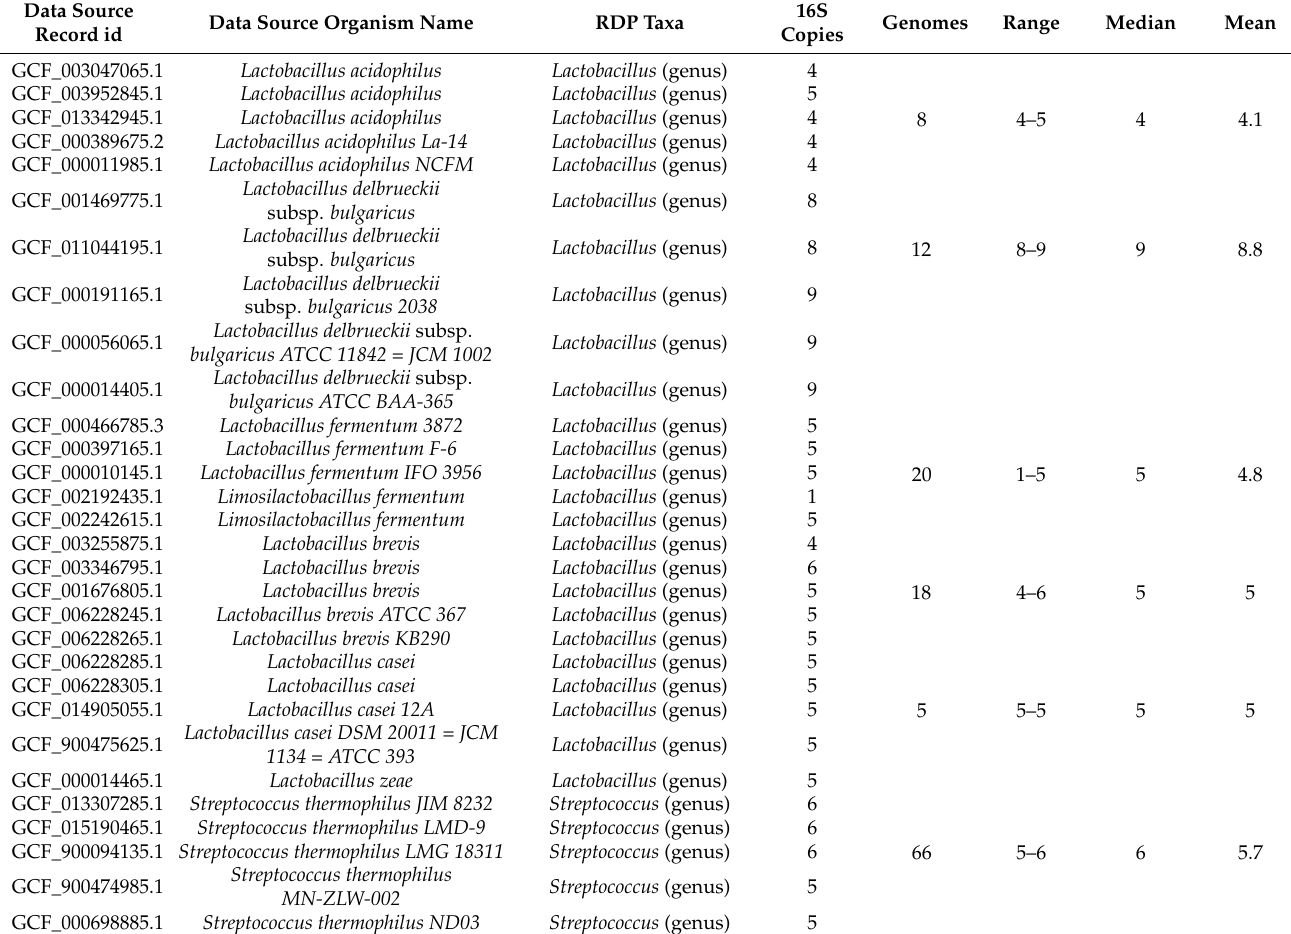
Table 4. The 16S rRNA gene copy number of 6 strains of lactic acid bacteria